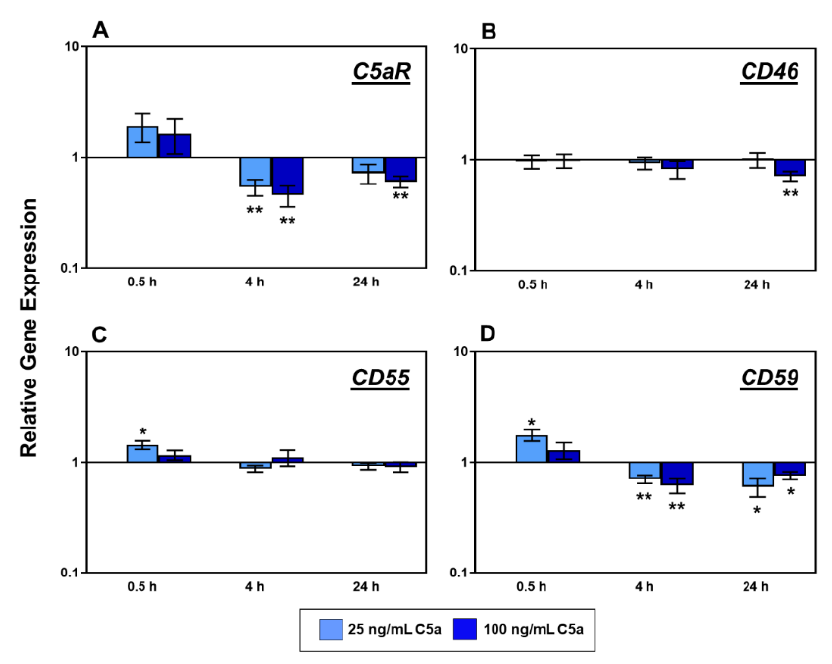
Figure 3. Tenocyte gene expression of C5aR ( A ), CD46 ( B ), CD55 ( C ) and CD59 ( D ) after 0.5 h ( n = 8), 4 h ( n = 7), and 24 h ( n = 6) stimulation with 25 ng/mL (light blue) and 100 ng/mL (dark blue) recombinant C5a protein in comparison to the non-stimulated control groups (normalized to 1, horizontal line). Mean values and the standard errors of mean are shown. Gene expression plotted as relative changes with logarithmic scale of Y-axes. Rout outlier test Q = 1.0%. Shapiro Wilk and Kolmogorov–Smirnov normality tests were performed to prove the normal distribution of data. One sample t -test with significance in relation to control (*). * = p ≤ 0.05; ** = p ≤ 0.01. 6–8 independent experiments with human tenocytes derived from different donors were performed.